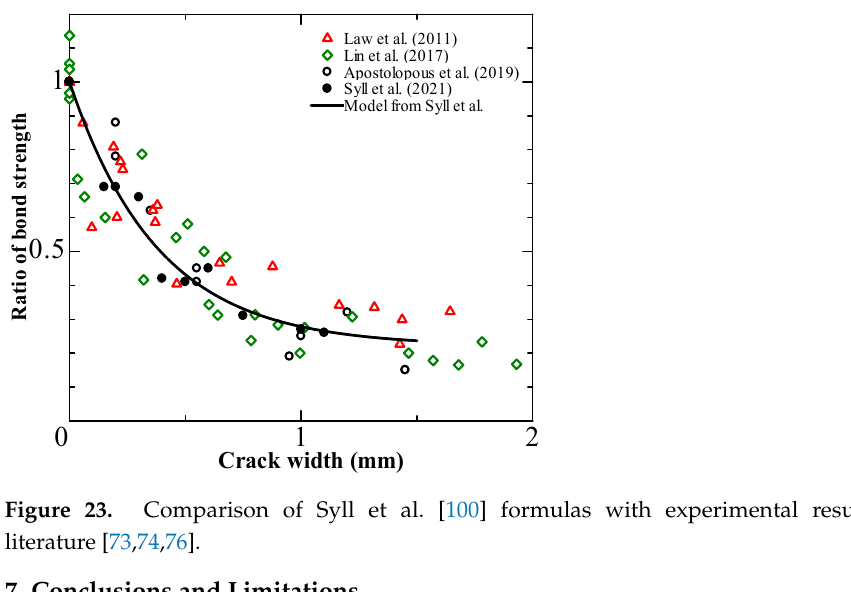
Figure 22. Cracking of concrete with EAFP: ( a ) cracking process; ( b ) filling with expansion; ( c ) example of cracking (adopted from Syll et al. [100]).